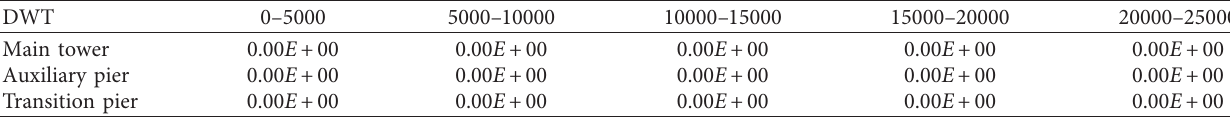
Table 8: The failure probability of each pier.